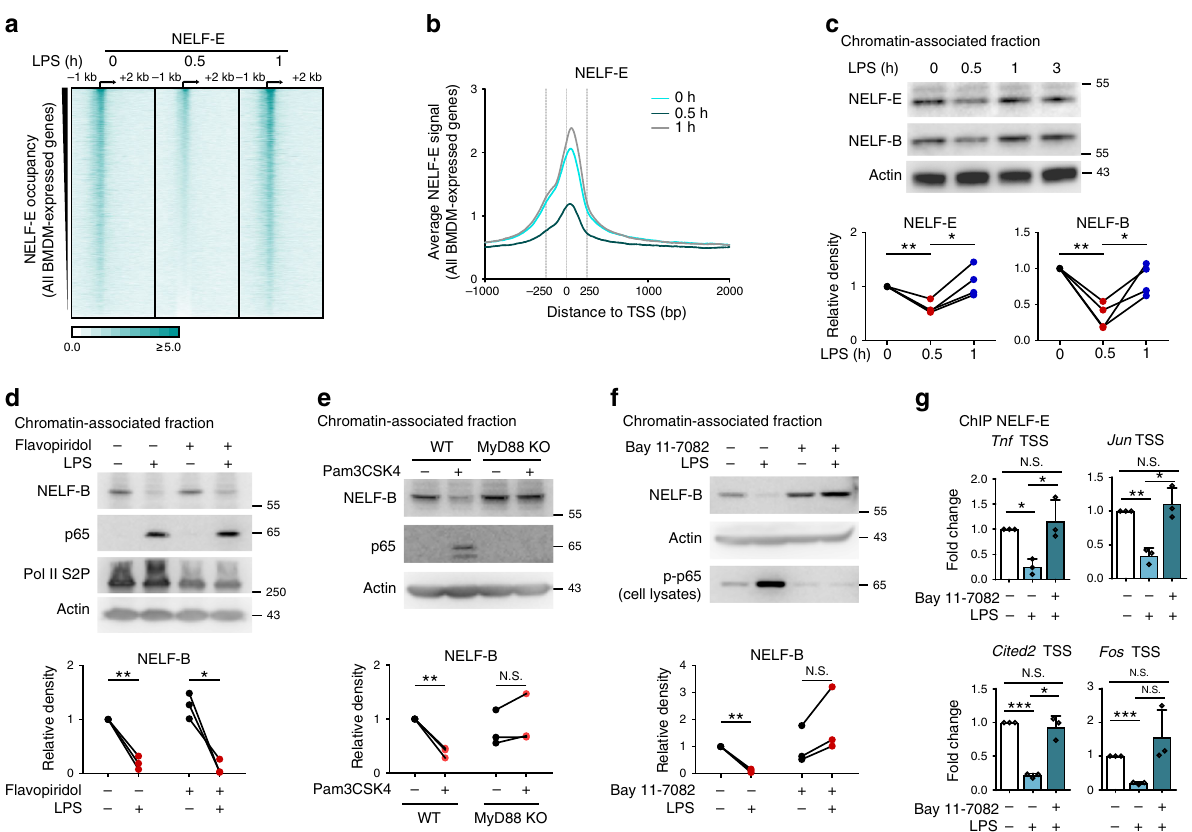
Fig. 4 NELF is globally and transiently released from chromatin upon macrophage activation. a , b Heat map ( a ) and average signals ( b ) of NELF-E ChIP- seq around TSS of all BMDM-expressed genes ( n = 10076 genes) for BMDM treated with LPS as indicated. The rows in a were sorted by decreasing NELF- E occupancy in TSS regions in resting BMDM. c Immunoblotting of chromatin-associated NELF-E, NELF-B, and actin in BMDM treated as indicated ( n = 4). NELF-E and NELF-B bands were quanti fi ed by densitometry, normalized to internal control (actin), and expressed relative to untreated (0 h) sample ( = 1) (bottom) (NELF-E LPS 0 h/0.5 h P = 0.0063, LPS 0.5 h/1 h P = 0.0138; NELF-B LPS 0 h/0.5 h P = 0.005, and LPS 0.5 h/1 h P = 0.0314). d Immunoblotting of chromatin-associated NELF-B, p65, Pol II S2P, and actin in mock (PBS) and fl avopiridol (300 nM)-pretreated (0.5 h) BMDM followed by LPS (0.5 h) ( n = 3). NELF-B bands in ( d , e , f ) were quanti fi ed and normalized as in ( c ) (bottom) (LPS 0 h/0.5 h P = 0.0077, fl avopiridol pretreated LPS 0 h/0.5 h P = 0.0322). e Immunoblotting of chromatin-associated NELF-B, p65, and actin in WT and MyD88 KO BMDM with or without Pam3CSK4 stimulation (10 ng/ml for 0.5 h) ( n = 3). Statistics of NELF-B bands (bottom) (WT/WT + Pam3csk4, P = 0.0081; MyD88 KO/MyD88 KO + Pam3csk4, P = 0.2311). f Immunoblotting of chromatin-associated NELF-B and actin in mock (DMSO) and Bay 11 – 7082 (5 μ M)-pretreated (0.5 h) BMDM followed by LPS (0.5 h). p-p65 blot is control for Bay 11-7082 activity ( n = 3). Statistics of NELF-B bands (bottom) (LPS 0 h/0.5 h, P = 0.0016; Bay 11 – 7082 pretreated LPS 0 h/0.5 h, P = 0.1042). g NELF-E occupancy in Tnf, Jun, Cited2, Fos TSS regions was assessed by ChIP-qPCR in mock (DMSO) and Bay 11 – 7082 (5 μ M)-pretreated (0.5 h) BMDM followed by LPS (0.5 h) ( n = 3) ( P values for different comparative conditions in Tnf , Jun , Cited2 , and Fos TSS are listed respectively: LPS 0 h/0.5 h P = 0.0137, 0.0094, 0.0006, 0.0006; LPS 0.5 h/LPS 0.5 h + Bay 11 – 7082, P = 0.0345, 0.0245, 0.023, 0.1082; LPS 0 h/LPS 0.5 h + Bay 11 – 7082, P = 0.5634, 0.5074, 0.5464, 0.3562). Mean + SD. * P < 0.05, ** P < 0.01, *** P < 0.001, N.S. P > 0.05 by two-sided paired Student ’ s t test. n represents biologically independen t experiments. Source data are provided as a Source Data fi (Fig. 4c). Of note, LPS-induced NELF chromatin dismissal and reloading were not a consequence of alterations in total cellular levels of the NELF complex as NELF-B and NELF-E protein abundance remained largely unchanged during the course of macrophage activation (Supplementary Fig. 4g).